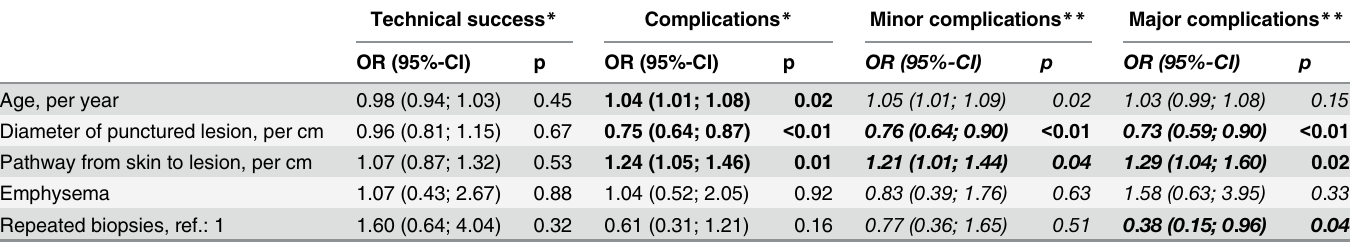
Table 1. Predictors of percutaneous transthoracic lung biopsies of potentially malignant pulmonary tumors: odds ratios (OR) with 95% confi- dence interval (CI) for technical success and complications (minor and major